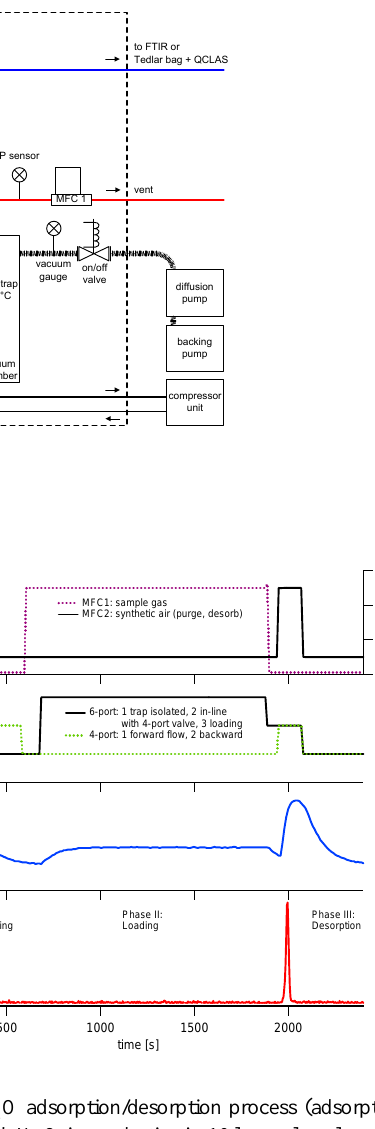
by a Nafion TM drier (MD-050-72S-1, PermaPure Inc., USA) and a chemical trap filled with Ascarite (3 g, 10–35 mesh, Fluka, Switzerland) bracketed by Mg(ClO 4 ) 2 (2 · 3 g,